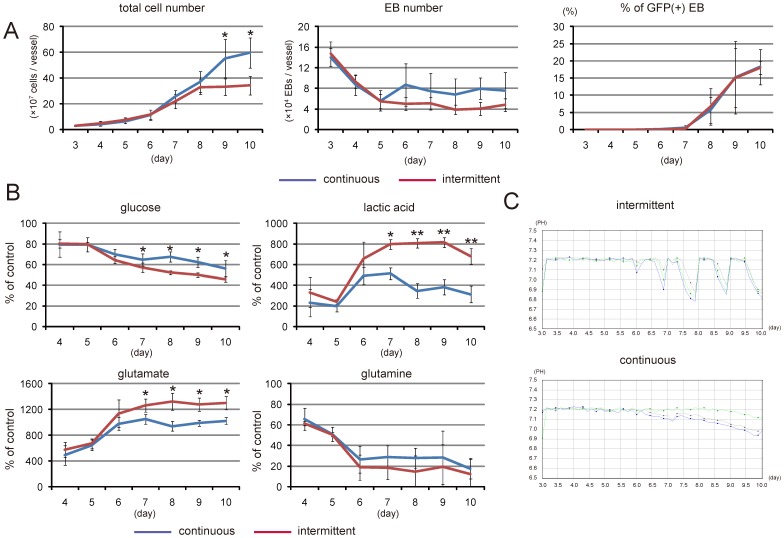
Expansion of ES cells in the bioreactor system.(A) Total cell number (left), the number of EBs (middle) in a vessel, and the percentage of GFP(+) EBs (right). Blue lines indicate the results of continuous medium exchange (n = 6), and red lines indicate the results of intermittent medium exchange (n = 6). *p<0.05. (B) Biochemical analysis of culture supernatants during bioreactor culture. Blue lines indicate the results of continuous medium exchange (n = 6), and red lines indicate the results of intermittent medium exchange (n = 6). *p<0.05, **p<0.01. (C) Trend graphs of the pH in bioreactor cultures. Upper, intermittent medium exchange; lower, continuous medium exchange. The Y-axis indicates pH, and the X-axis indicates the day of culture. Each line in the graphs indicates the pH trend of three independent experiments.